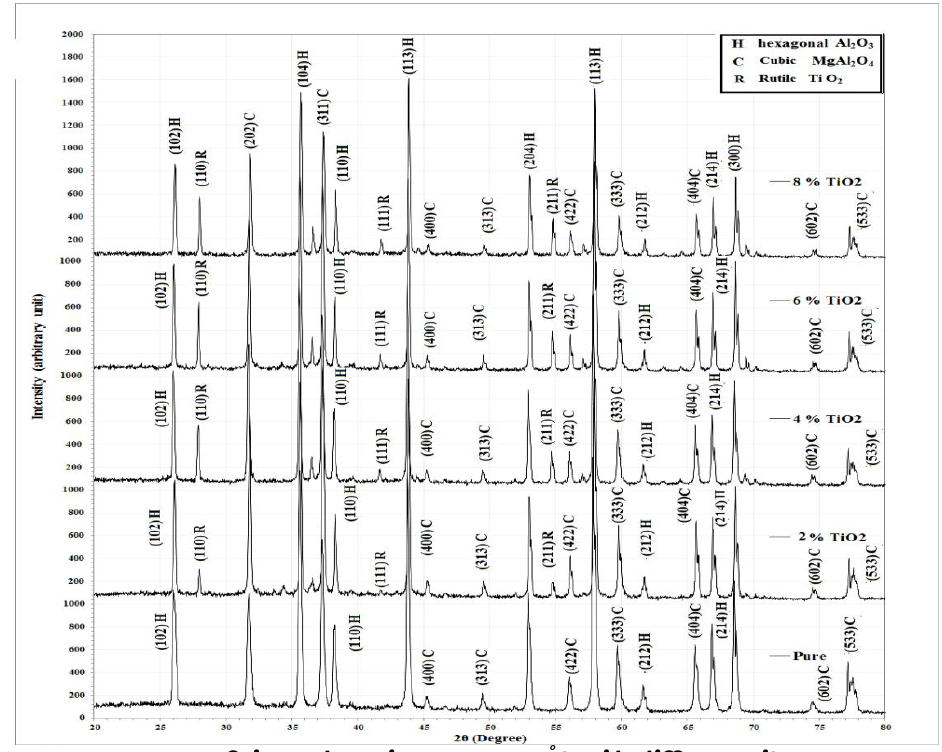
content. 2 O ) the addition oxide (TiO ) in 2 4 2